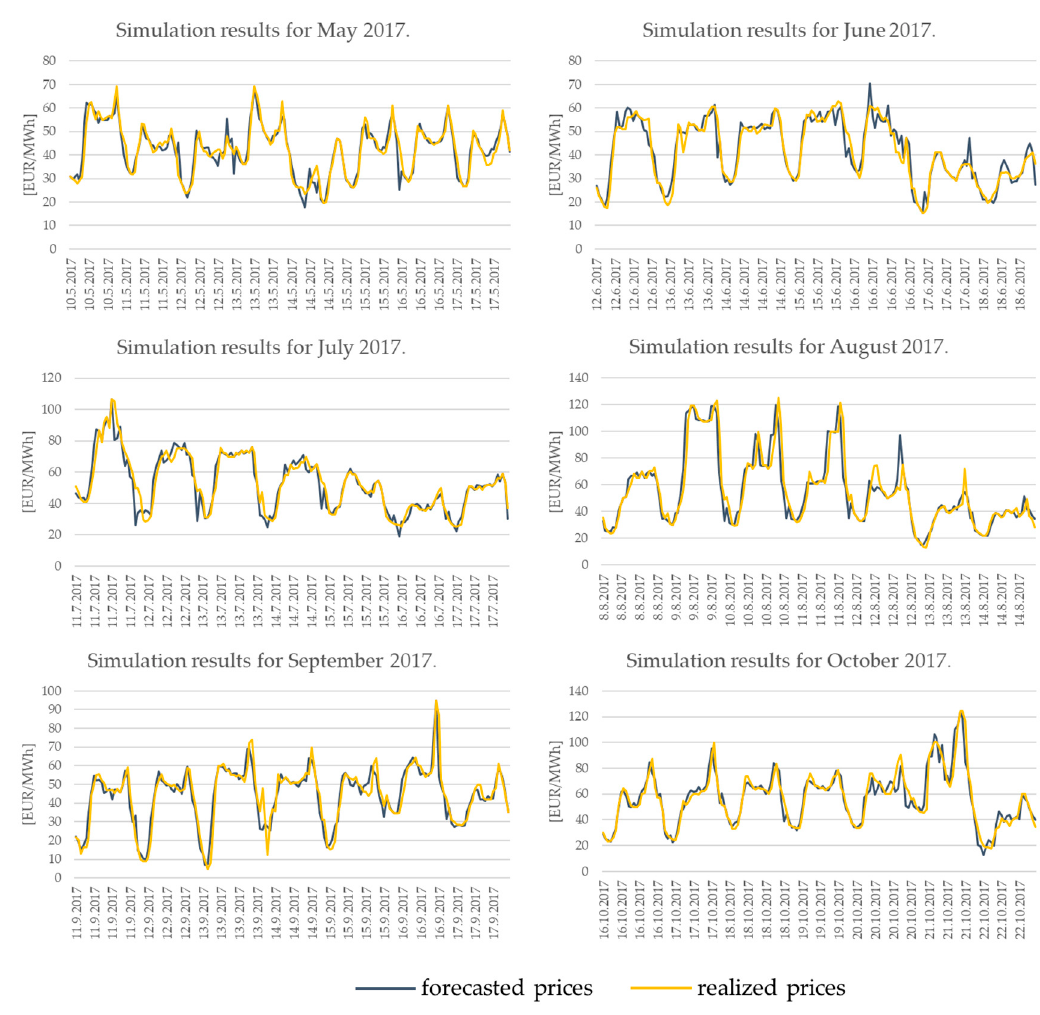
Figure 18. Forecasted and actually realized hourly prices in second forecasting interval for the period from May 2017 to October 2017.